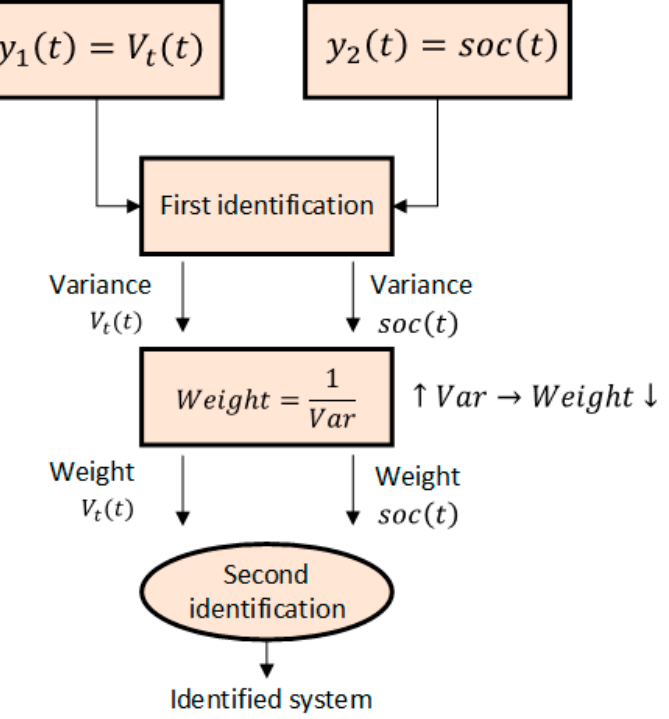
Figure 2. System identification strategy for battery modeling based on different output weights.